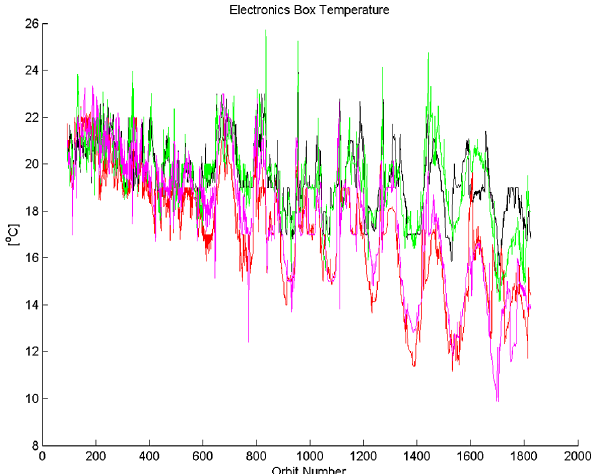
Figure 2. Outboard sensor temperatures in degrees Celsius for each spacecraft for orbits 93–1889 (February 2001–August 2012). C1 – black, C2 – red, C3 – green, C4 – magenta.